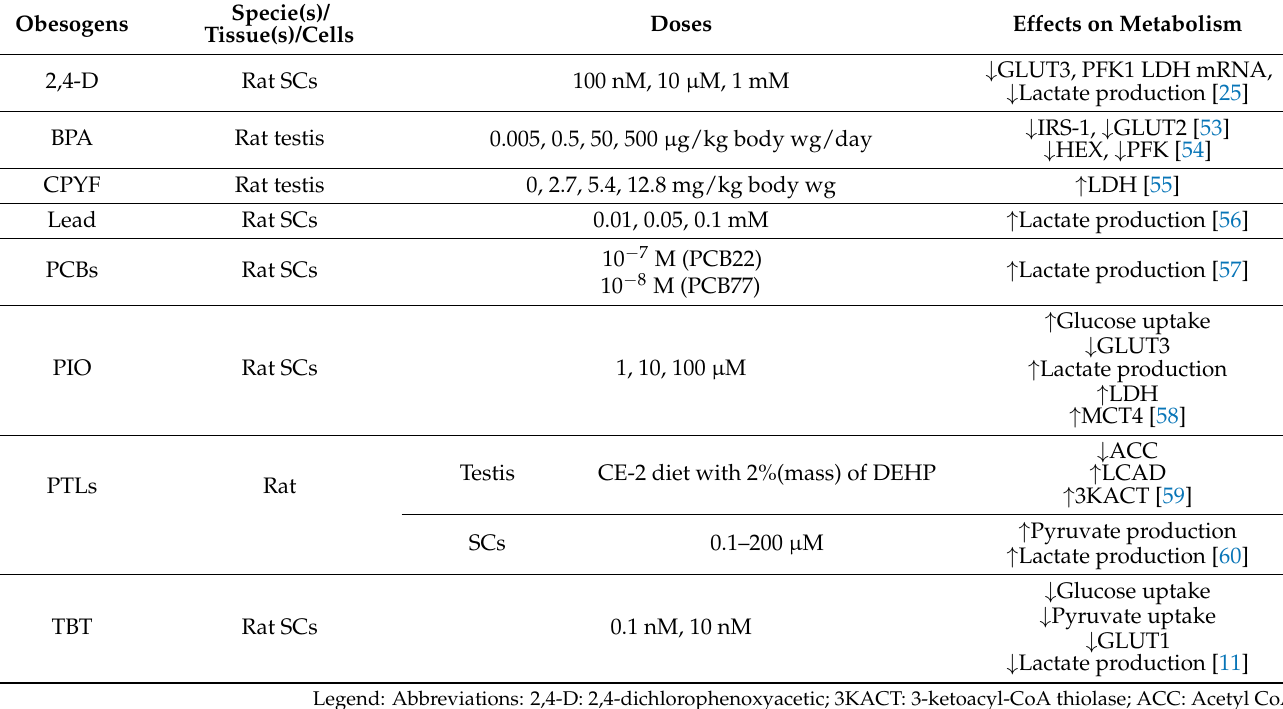
Table 1. Summary the main obesogens and their proposed effects on metabolism in reproductive cells/tissues of